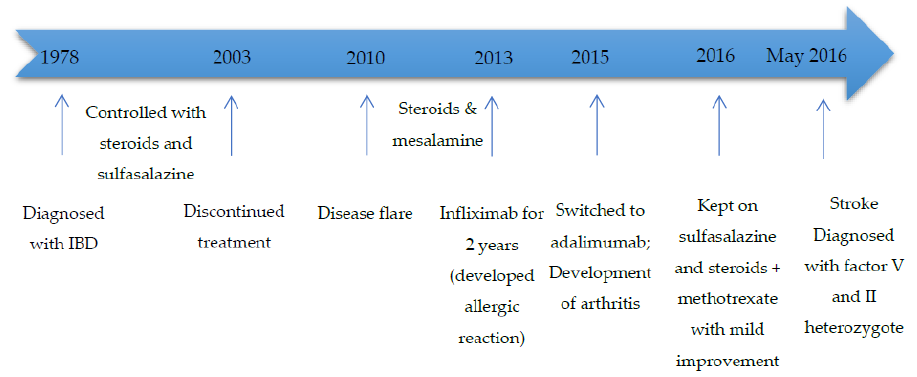
Figure 1. Summary of events for case I. IBD: inflammatory bowel diseases.